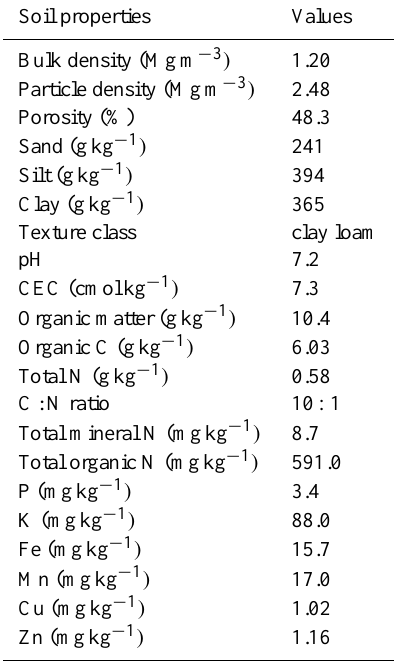
Table 1. Selected physicochemical properties of the soil used in the